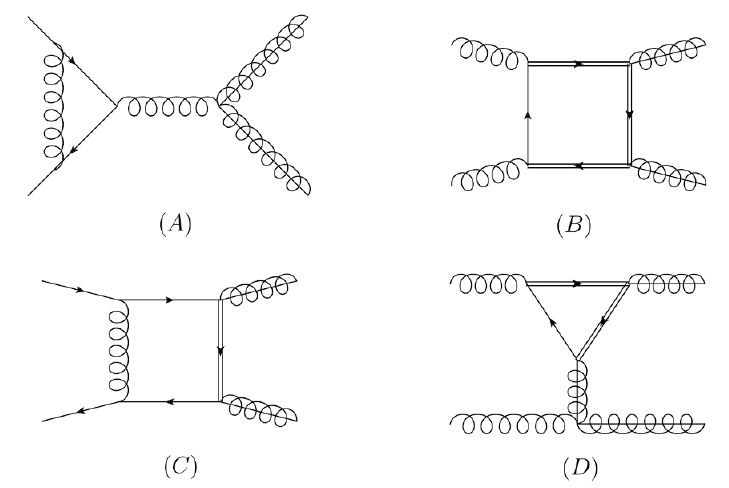
Figure 2 . Sample one-loop diagrams contributing to coloron pair production. See (cid:12)gure 1 for the de(cid:12)nition of the di(cid:11)erent propagator line types.